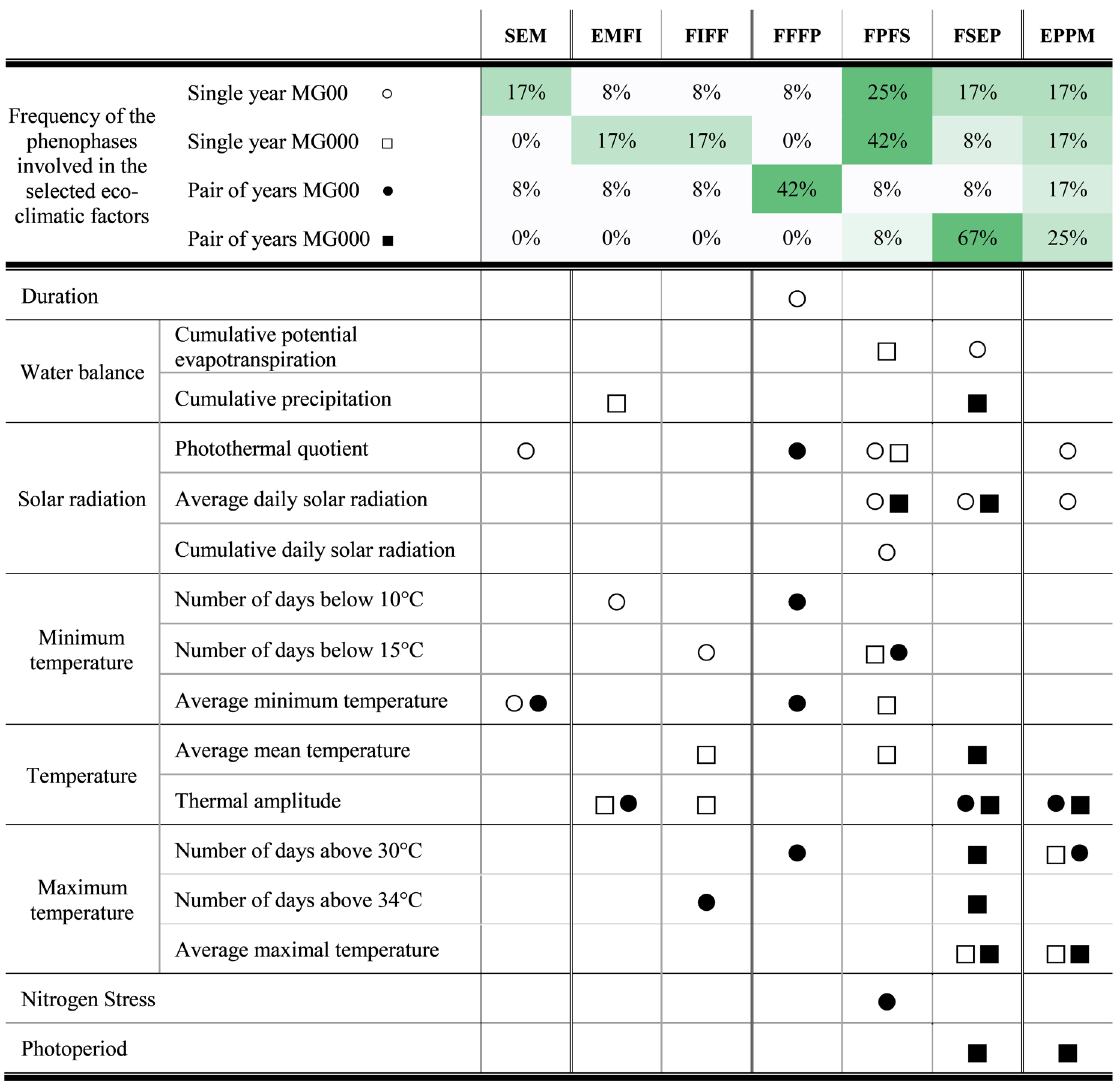
Figure 3. Frequency of phenophases and repartition of the eco-climatic factors selected for their main impact on genotype by environment interactions in the different meta-analyses. Twelve eco-climatic factors were selected for the analyses on ○ single year by MG00, □ single year by MG000, ● pair of years by MG00 and ■ pair of years by MG000. (SEM: Sowing to Emergence; EMFI: Emergence to Flower Induction; FIFF: Flower Induction to First Flower; FFFP: First Flower to First Pod; FPFS: First Pod to First Seed; FSEP: First Seed to End Pod; EPPM: End Pod to Physiological Maturity). The double horizontal bars separate the growth phases: emergence, vegetative growth, reproductive growth and grain filling.